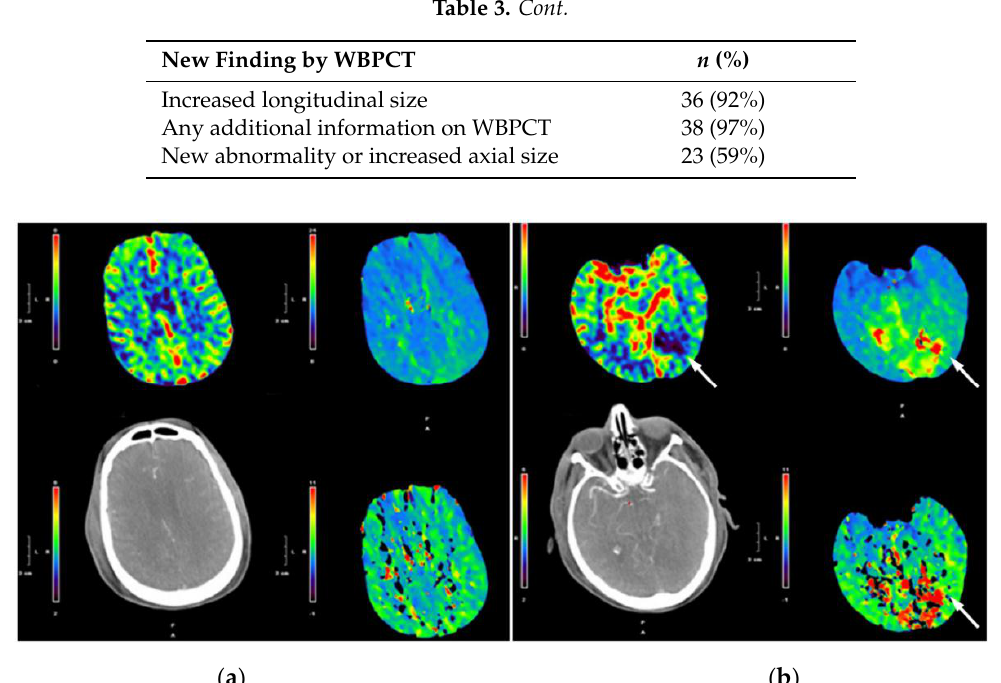
Figure 1. Example of LBPCT ( a ) and WBPCT ( b ) demonstrating a new area of perfusion abnormality not visible by LBPCT (arrowed).